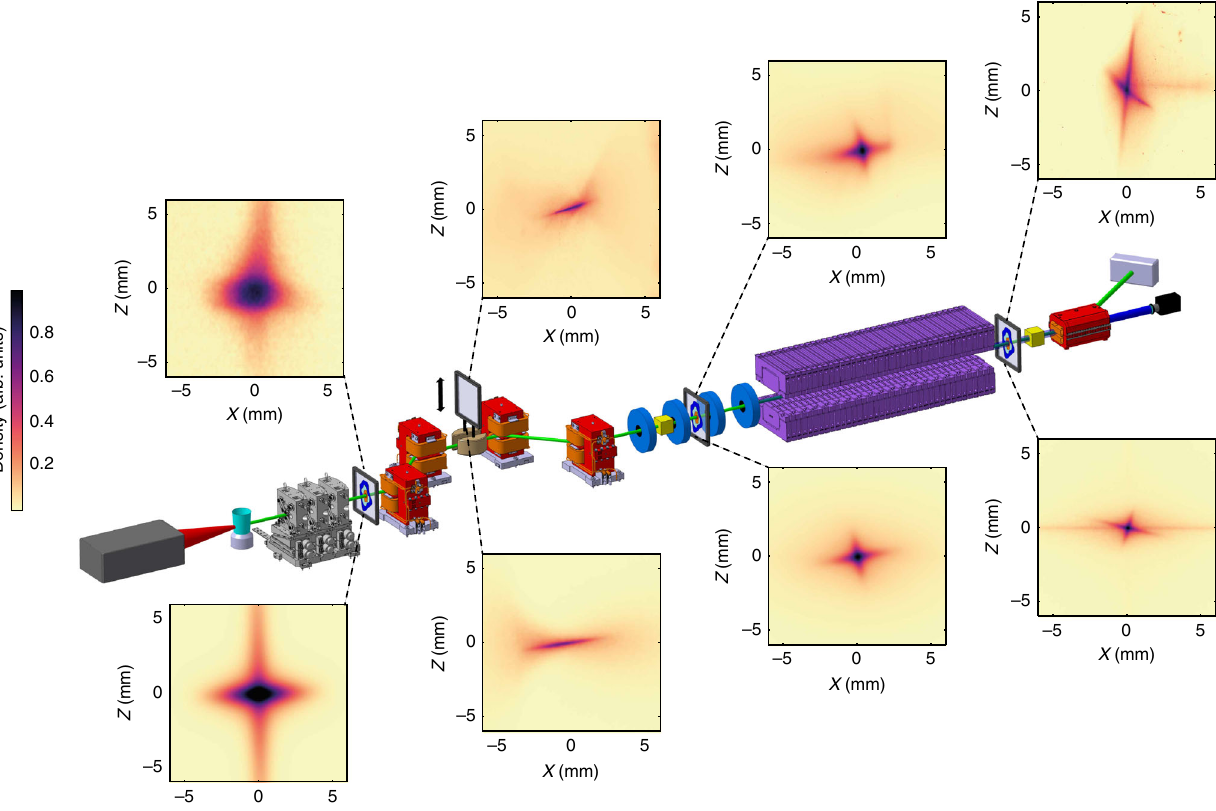
Fig. 1 Scheme of the COXINEL manipulation line: laser hutch (grey), gas jet (cyan), removable permanent magnet quadrupoles (grey) which can be replaced by an electron spectrometer, magnetic chicane (dipole magnet in red) with a slit (brown) inserted in the middle of the chicane, electromagnetic quadrupoles (blue), undulator (purple), cavity beam position monitors (yellow), dipole dump (red), beam dump (grey) and CCD camera (black). LANEX and YAG screens for electron beam imagers. Measured (top) and simulated (down) electron beam transverse pro fi les (horizontal: x and vertical: z direction) along the